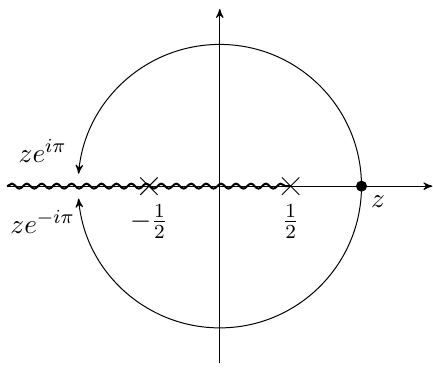
Figure 3 . Analytic structure of F ( z ) and paths of analytic continuation to negative z .